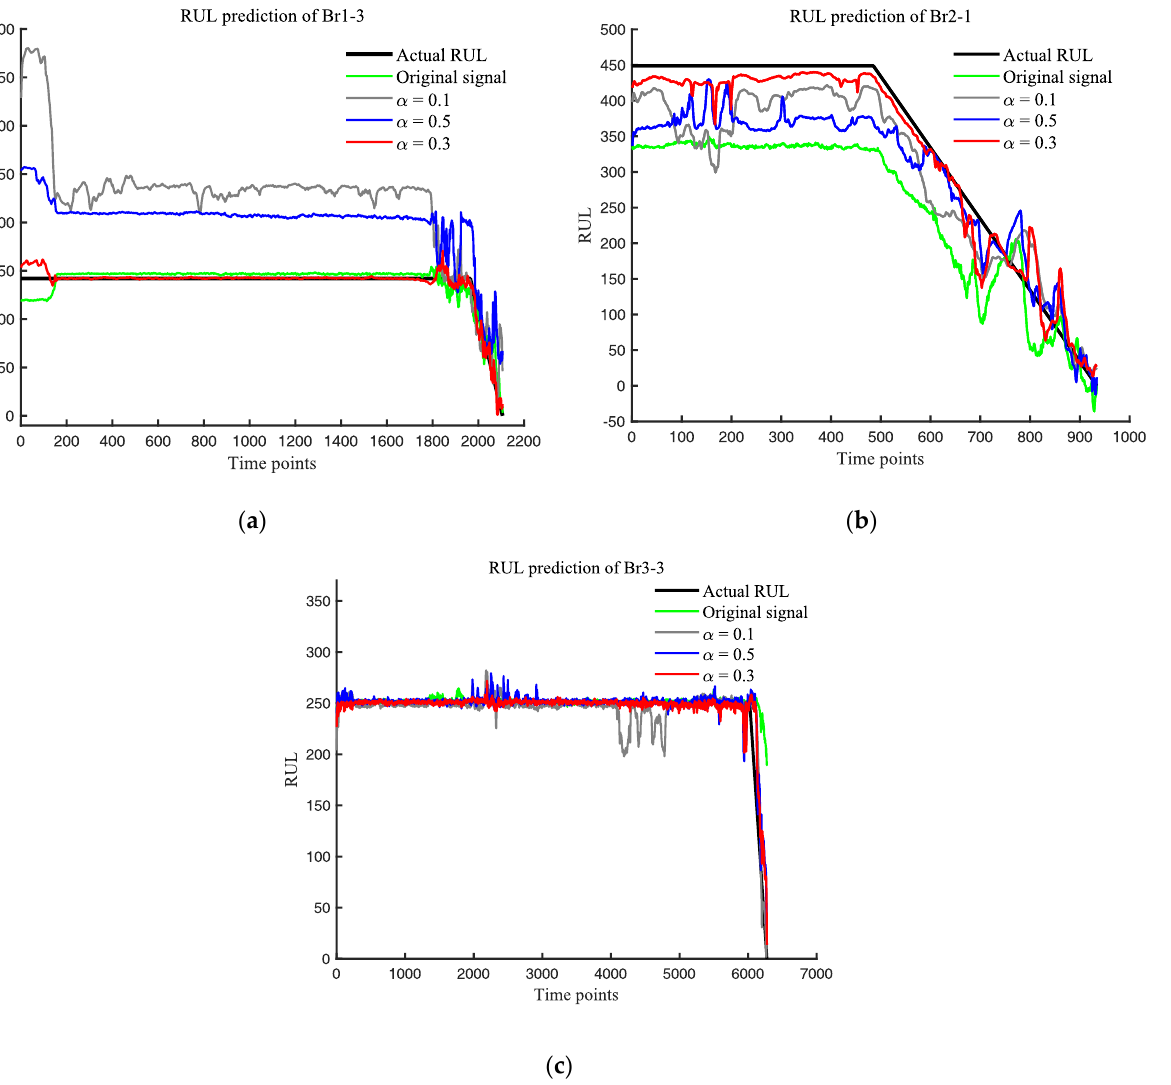
Figure 9. ( a ) Performance of ES on peak-to-peak of Br1-3; ( b ) performance of ES on standard devia- tion of Br2-1; ( c ) 3; ( b ) performance of ES on gravity frequency of Br3-3.